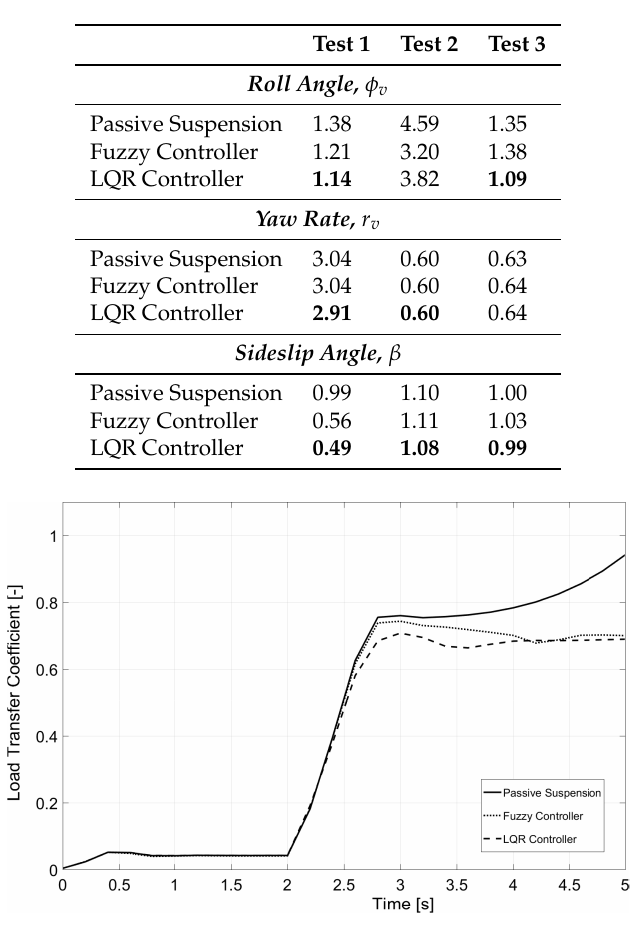
Table 2. Normal error values, E k .